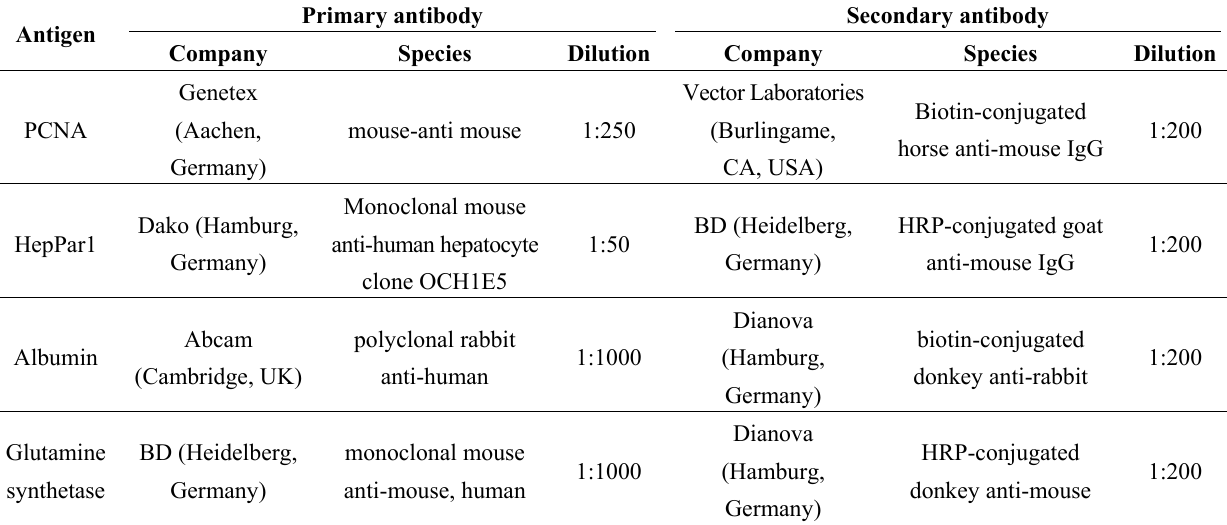
Table 2. Antibodies and dilutions used for